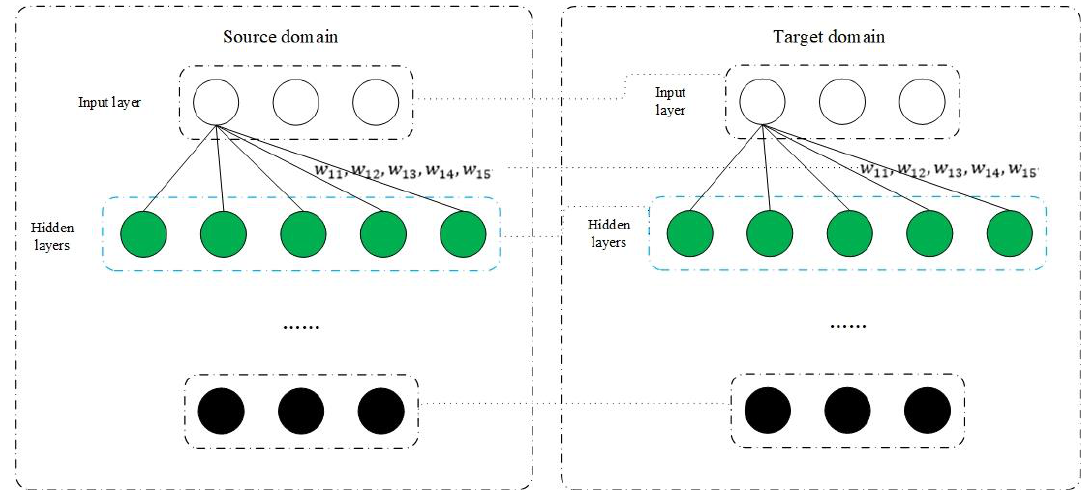
Figure 2. TS1 Transfer both structure and weights of network simultaneously.